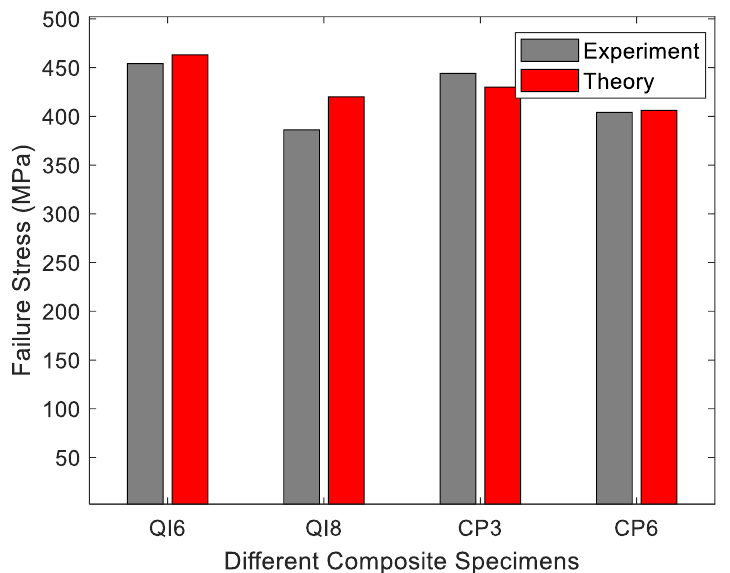
Figure 6. Comparison of failure stress between analytical and experimental results of laminated carbon fiber composite specimens with a hole at the center.